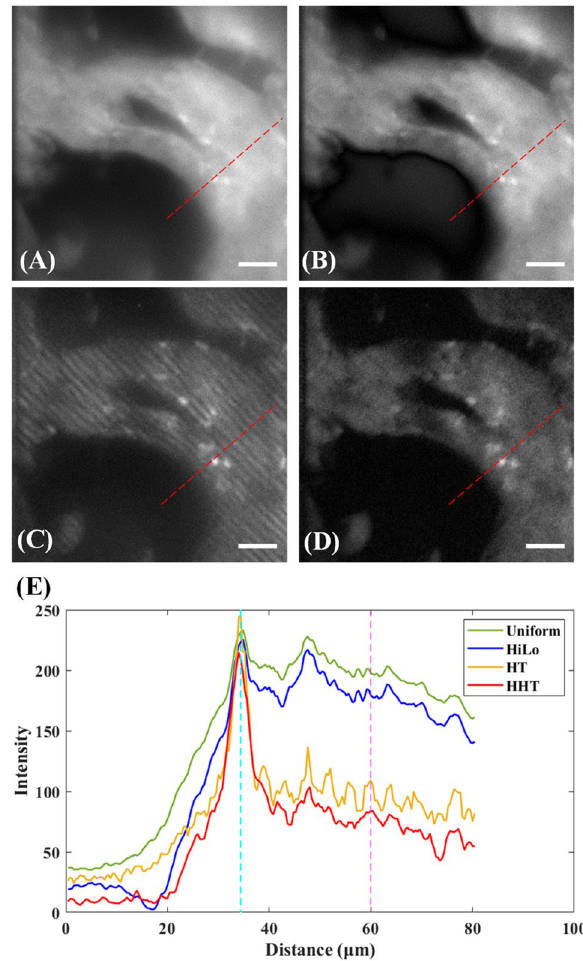
Figure 4. ( A ) Original TFMPEM image with uniform illumination, and reconstructed images obtained using: ( B ) HiLo, ( C ) Hilbert transform, and ( D ) Hilbert–Huang transform. ( E ) Intensity profile along red dashed line in each figure. Note that the scale bar indicates 20 μm in every